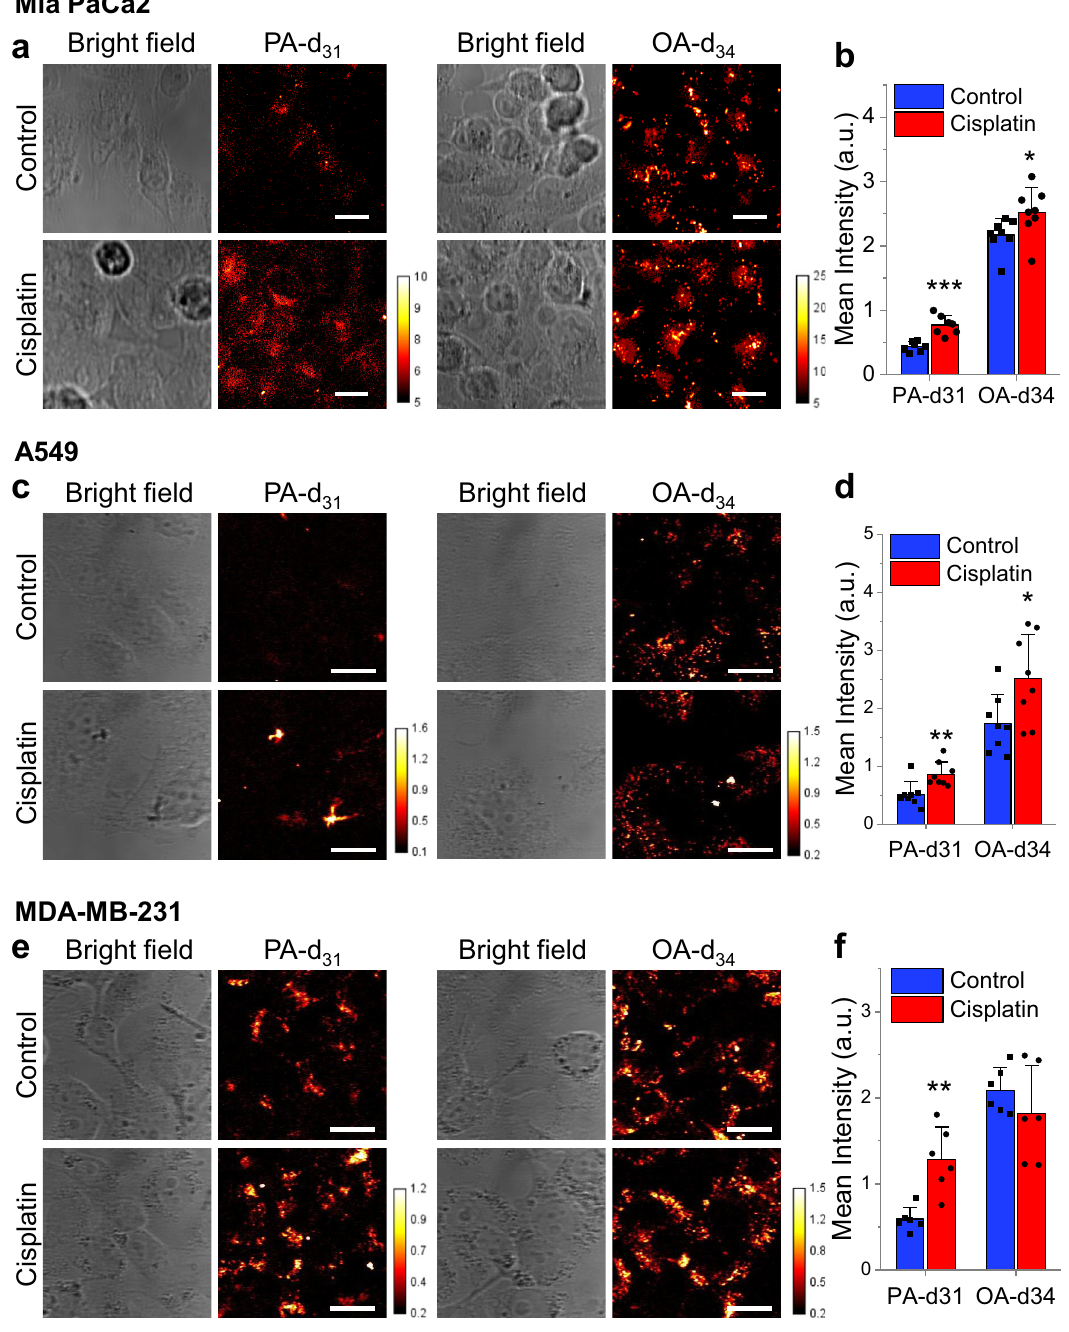
Fig.7|CisplatininducedFAuptakeisauniversalmetabolicfeatureinmultiple types of cancers. a Representative bright fi eld and SRS images of MIA PaCa2 cells treated with 6.6 μ M cisplatin for 24h followed by 100 μ M PA-d 31 or OA-d 34 incu- bation for 6h. b Quantitation of C-D signal in MIA PaCa-2 cells treated with or without cisplatin by mean intensity. n =7 for PA-d 31 and n =8 for OA-d 34 . P =0.00029 and 0.026. c Representative bright fi eld and SRS images of A549 cells treated with 13.2 μ M cisplatin for 48h followed by 100 μ M PA-d 31 or OA-d 34 incu- bation for 6h. d Quantitation of C-D signal in A549 cells treated with or without